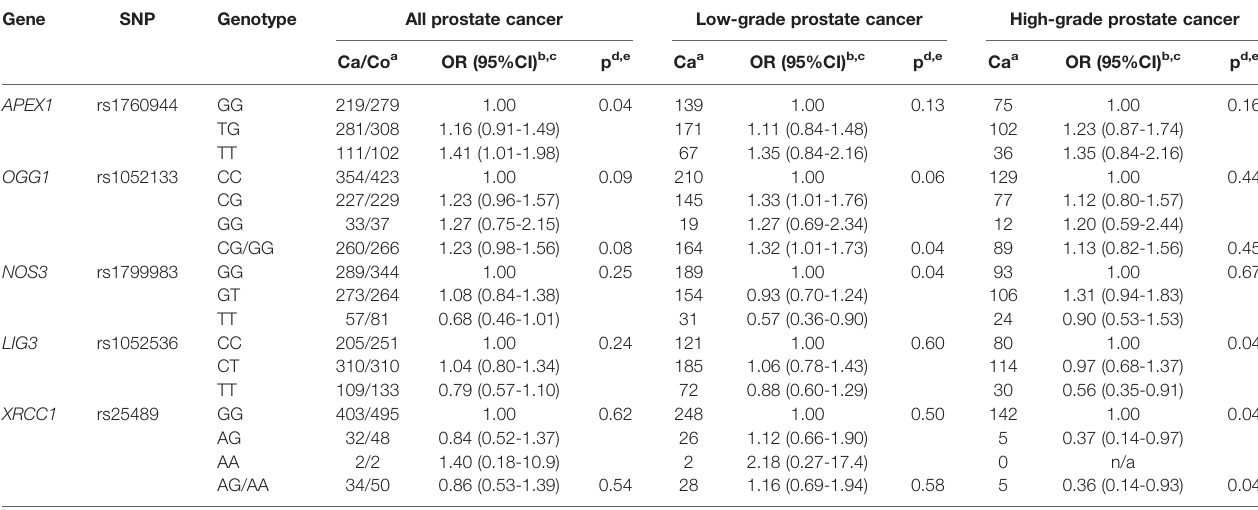
TABLE 2 | Signi fi cant associations between polymorphisms in oxidative stress and DNA repair genes and prostate cancer risk in PCPT fi nasteride arm. Gene